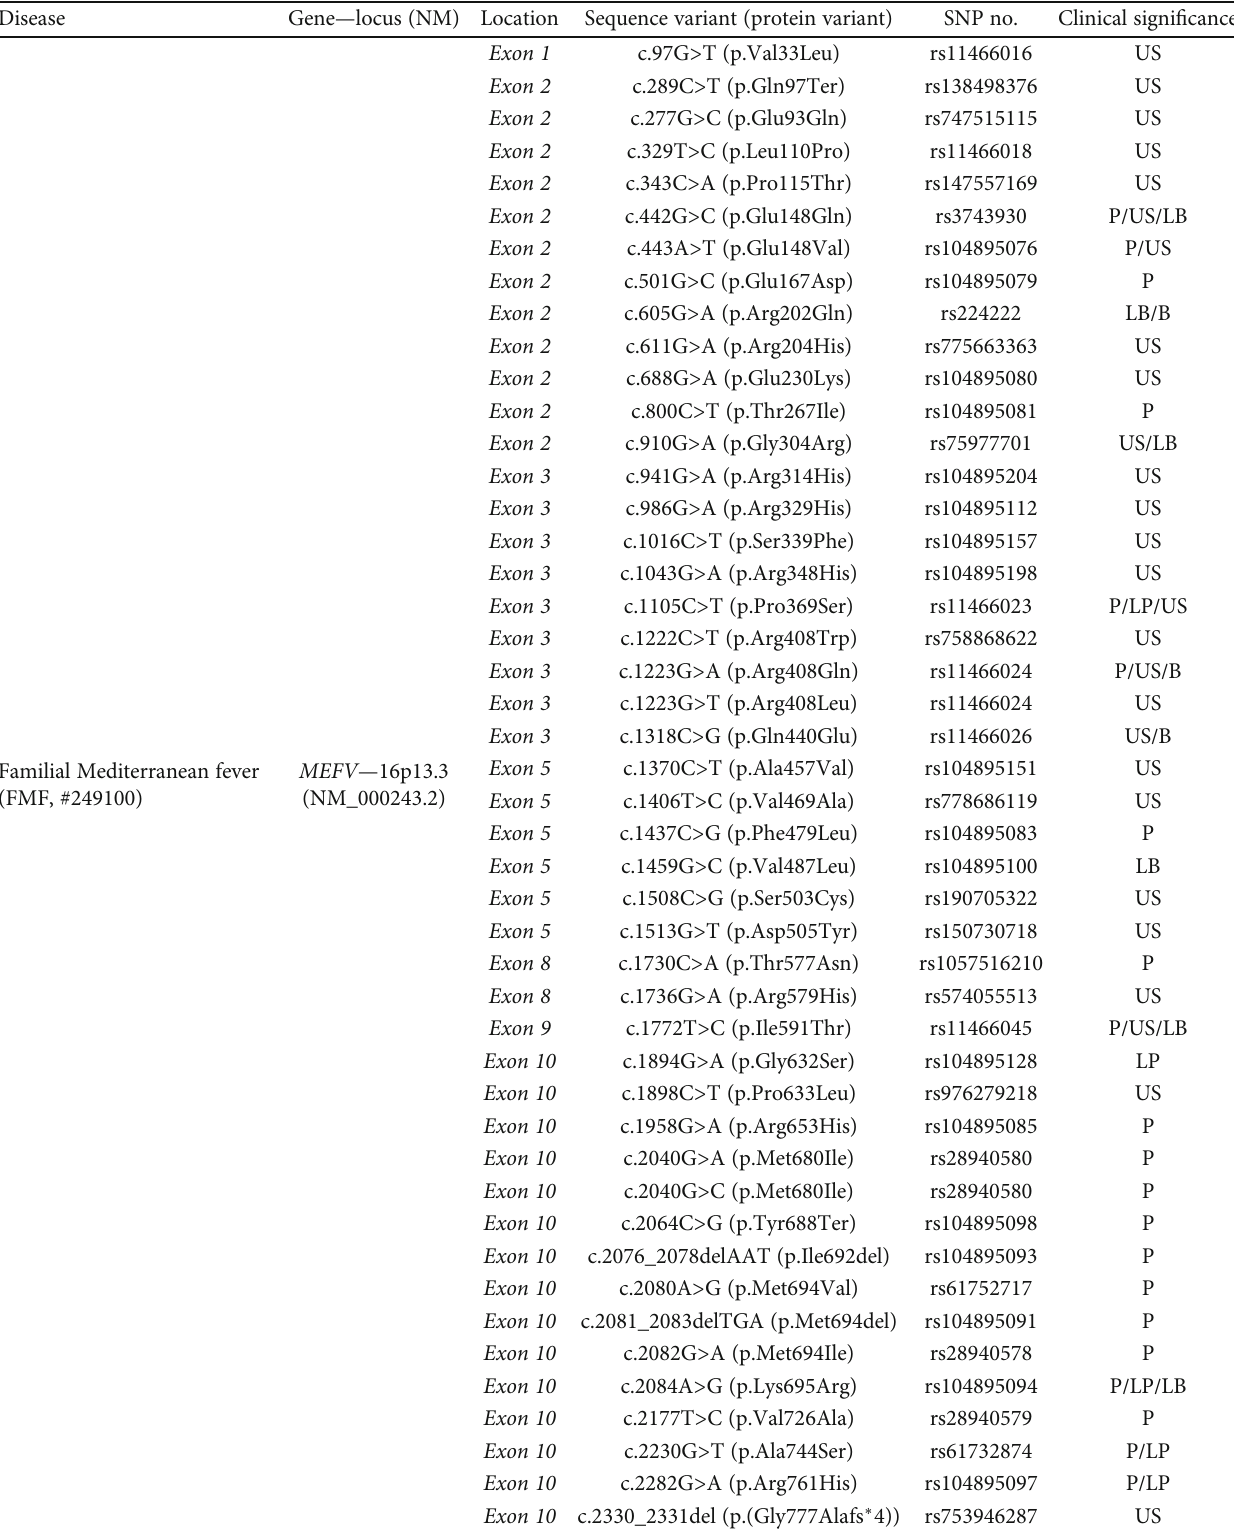
Table 7: Genetic variants associated with hereditary recurrent febrile syndromes and interpretations of their signi fi cance (from ClinVar